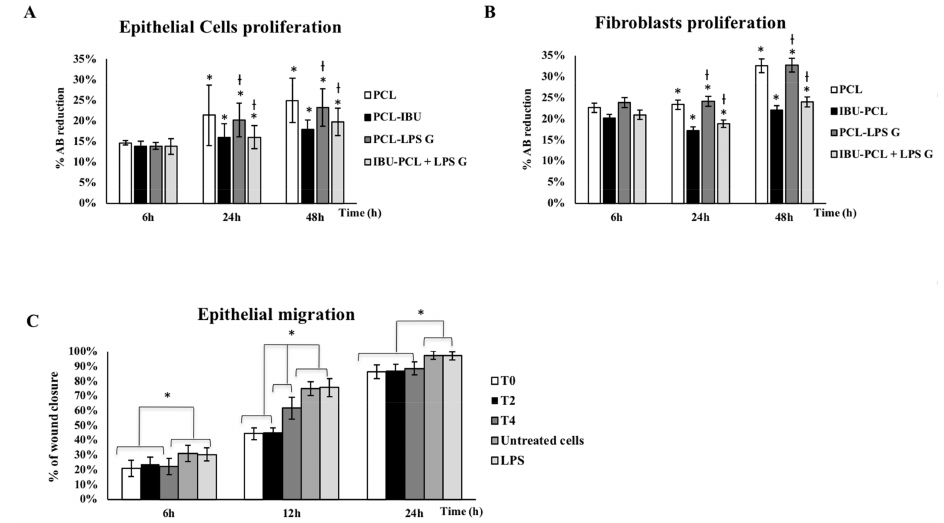
Figure 2. Proliferation of EC ( A ) and FB ( B ) after 6, 24 and 48h and EC migration after 6–24 h ( C ). These different conditions have been measured by using the AlamarBlue test ( A , B ). EC and FB proliferation has been evaluated on PCL and IBU-PCL membranes and with or without Pg -LPS stimulation. Data are expressed as the mean ± SD. * Difference between cells with or without IBU, p < 0.05, † difference between stimulated cells with or without IBU, p < 0.05. Epithelial migration has been evaluated through the in vitro scratch assay ( C ) after injection of IBU (50 µ g/mL) at baseline (T0), 2 h (T2) and 4 h (T4) at 6, 12 and 24 h in EC stimulated with Pg -LPS. Data are expressed as the % of wound closure ± SD; * p <